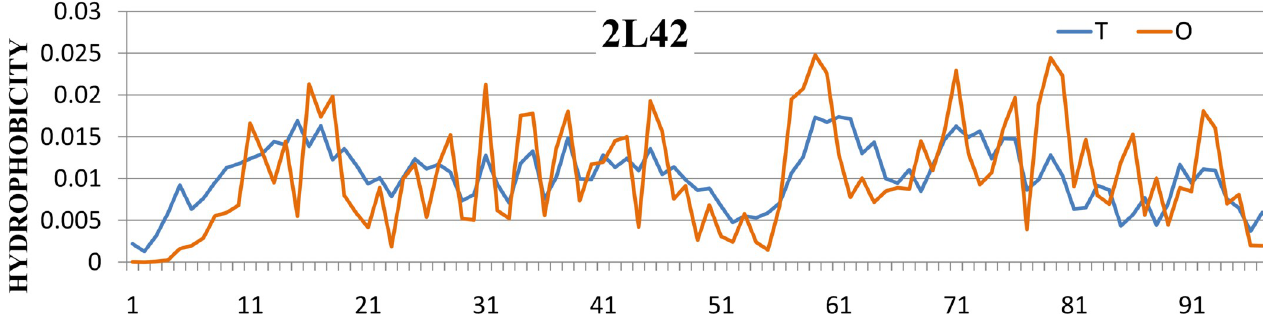
Fig 9. The T and O distributions for 2L42 protein (profile M for K = 0.0 coincides with profile T ).